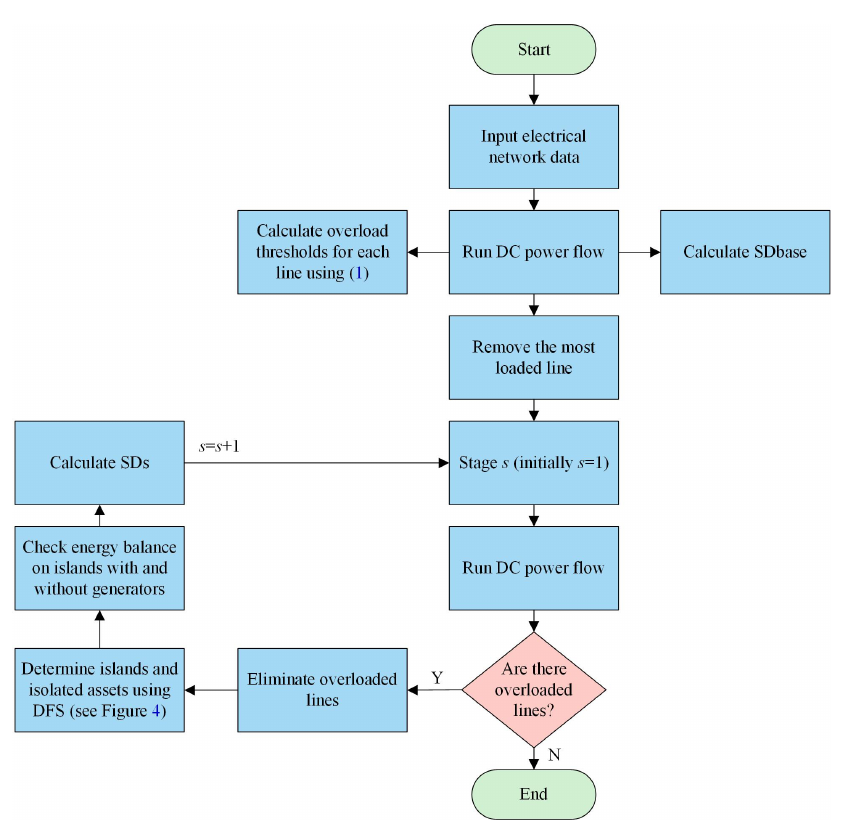
Figure 3. Flowchart of Algorithm